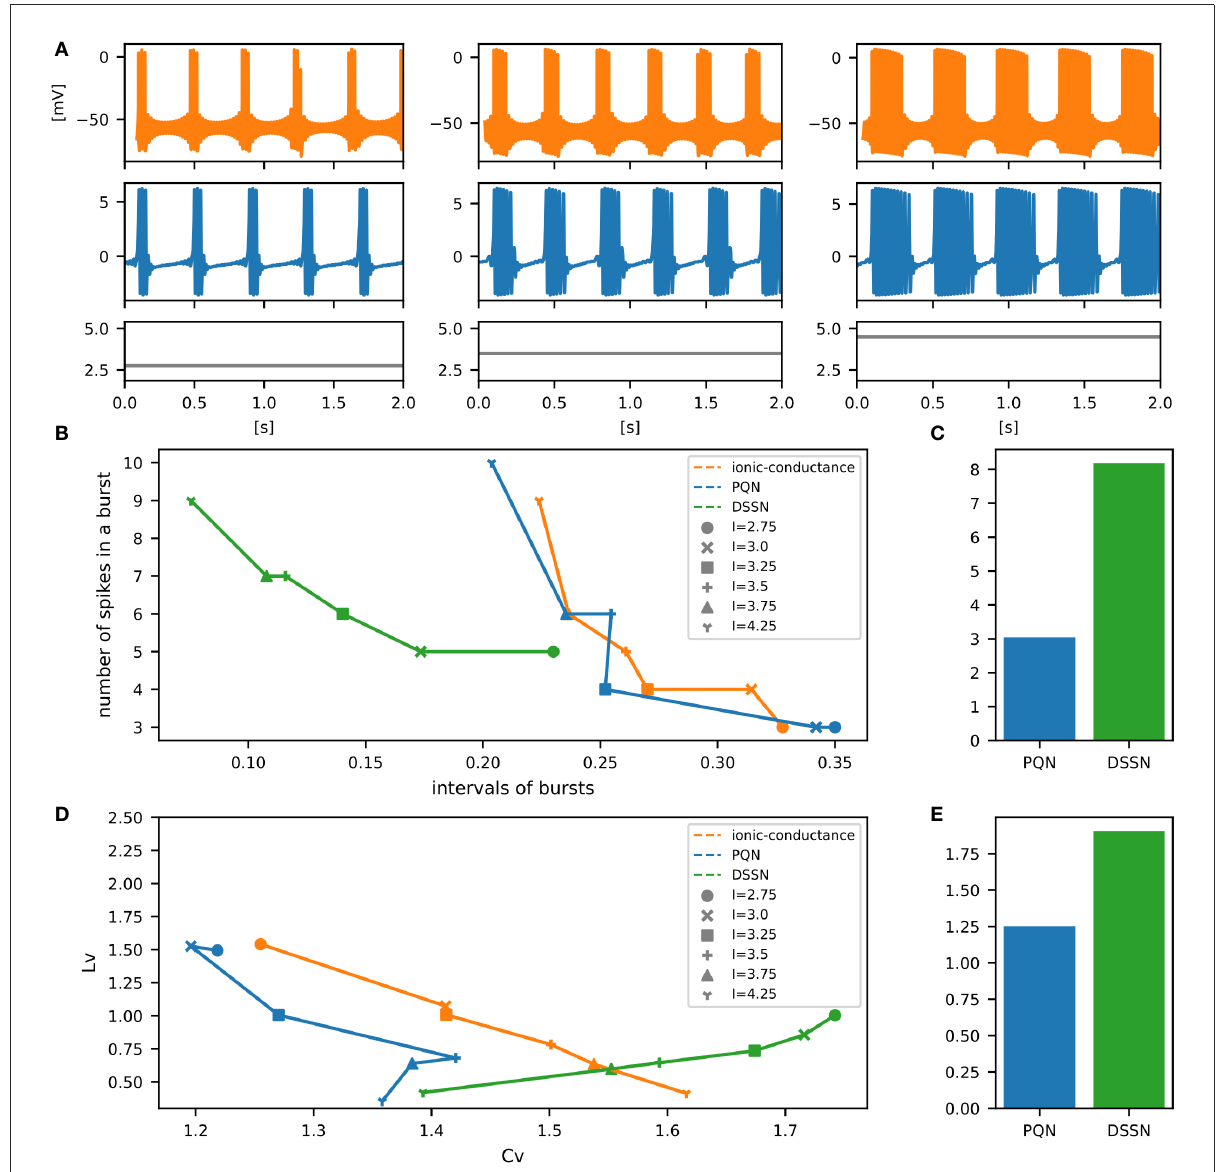
FIGURE11 Waveforms and spiking properties in EB mode. (A) Waveforms of the ionic-conductance model (orange) and the PQN model (blue). Gray lines represent stimulus inputs. (B) Properties of bursting. The horizontal axis represents the interval between bursts, and the vertical axis represents the number of spikes in a burst. Stimulus inputs were increased by 0.25 from 2.75 to 4.25. (C) The mean square errors of the PQN model and the DSSN model with the ionic-conductance model over the data points shown in (B) . (D) Values of the C V and L V were calculated from the waveforms and plotted while varying the magnitude of the stimulus inputs. (E) The mean square errors of the PQN model and the DSSN model with the ionic-conductance model over the data points shown in (D) .